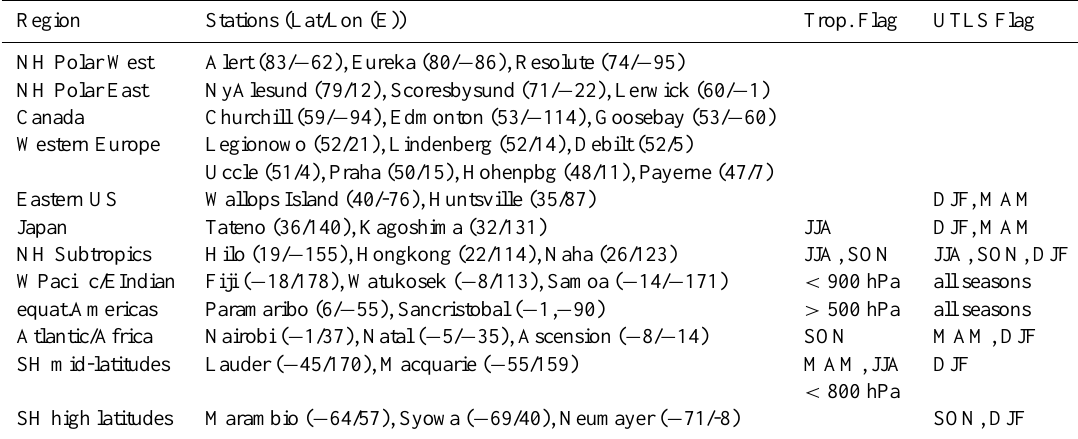
Fig. 3. Same as Fig. 2, but for tropopause-referenced altitude coordinates instead. Table 2. Summary of the selected regions, tropospheric and UTLS flags show cases where ozone PDFs and median values of single stations in the particular region and season show a variablility of more than ≈ 10ppb in the troposphere or 15% in the UTLS, and the Hellinger distance is larger